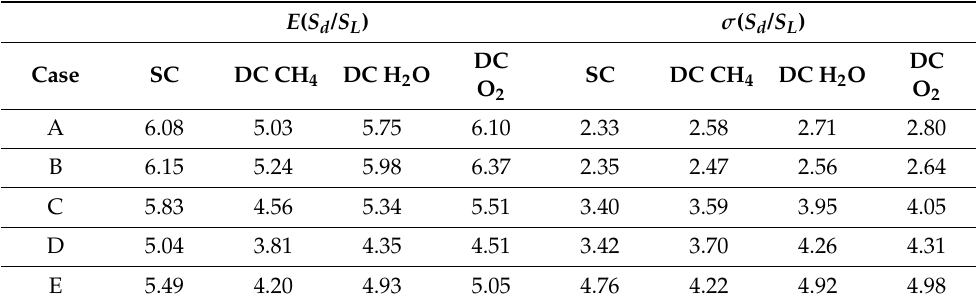
Figure 6. PDF of normalised displacement speed S d / S L on c = 0.8 progress-variable isosurface for cases A–E for ( a ) SC and ( b – d ) DC simulations for reaction progress variable based on CH 4 , H 2 O, O 2 mass fractions. Table 6. Mean value E and standard deviation δ of normalised displacement speed S d /S L for the c = 0.8 isosurface for all